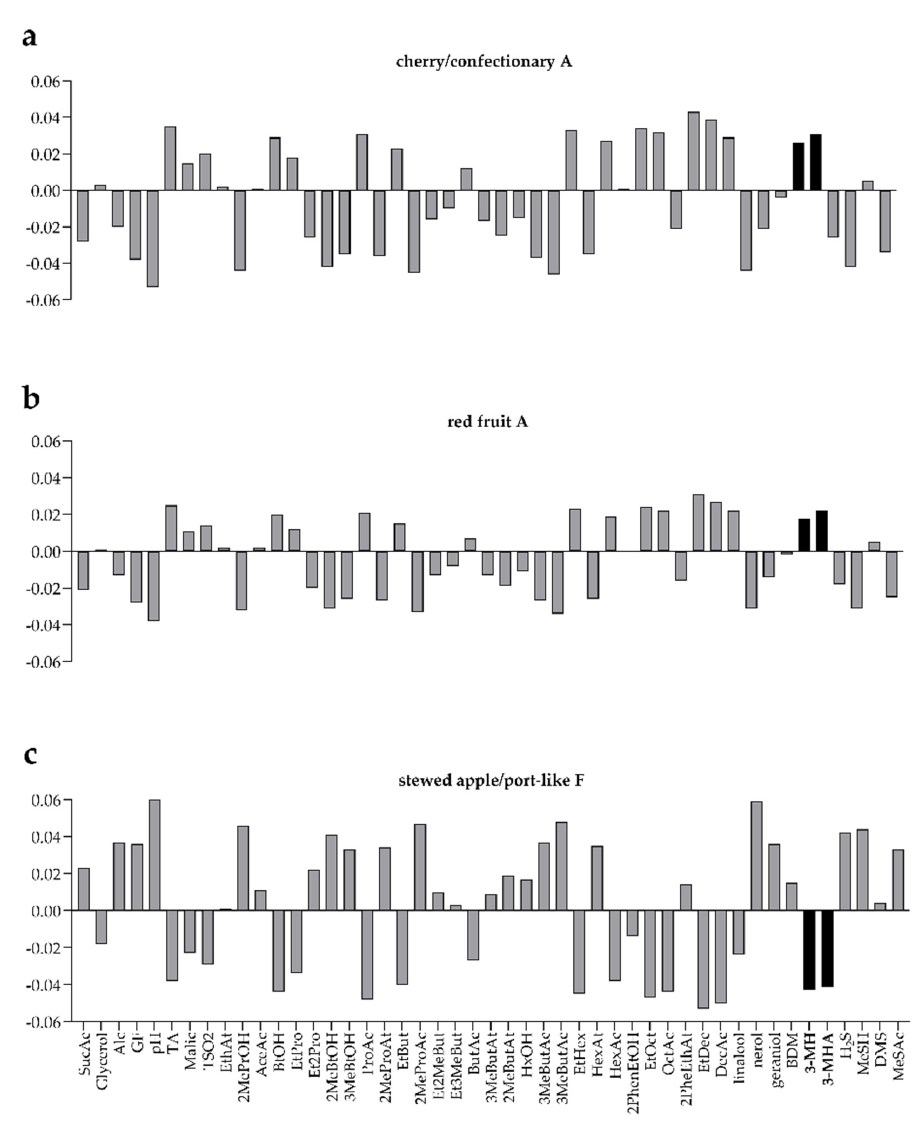
Figure 7. Regression coefficients from a partial least squares (PLS) model generated to relate volatile composition for the 6 Grenache wines made with different yeast strains with aroma (A) and flavour (F) attributes: ( a ) cherry/confectionary A, ( b ) red fruit A, ( c ) stewed apple/port-like F. Polyfunctional thiols 3-MH and 3-MHA are shown as black bars. Abbreviations of volatiles can be found in Table S8.